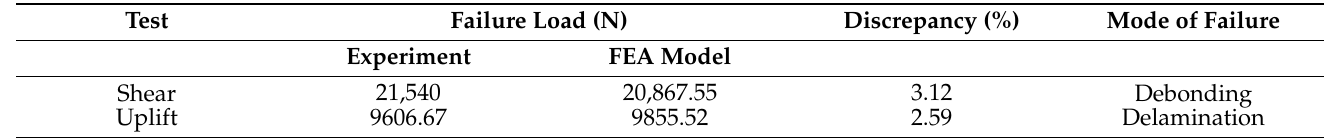
Table 1. Comparison between experimental and FE model data.